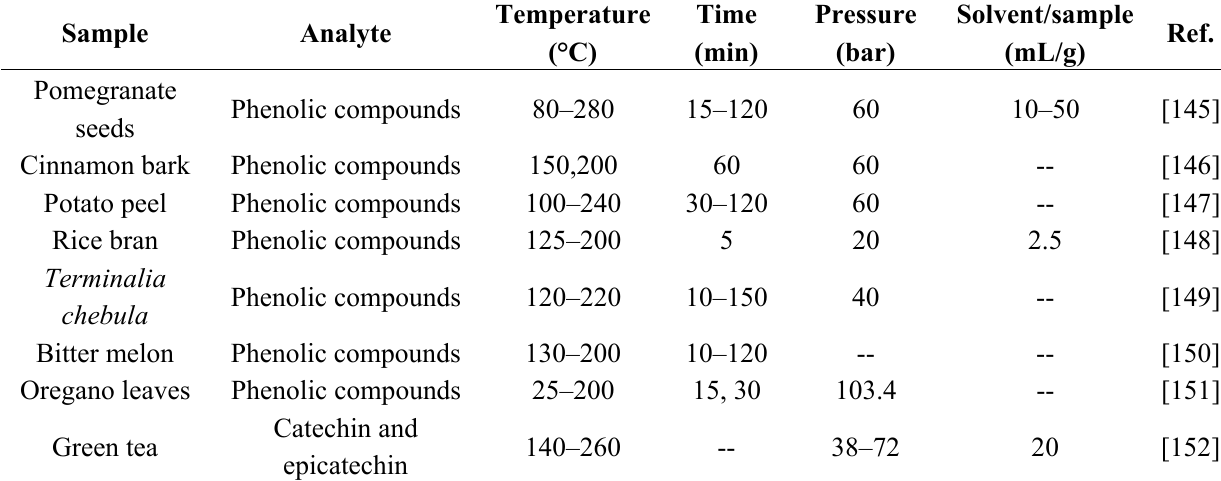
Table 7. Conditions for SCWE of phenolic compounds from plant-based